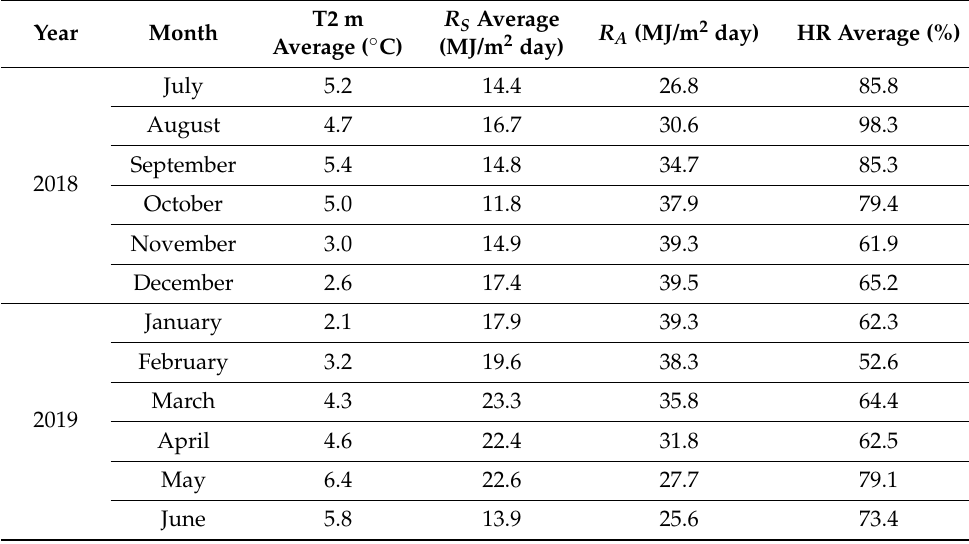
Table A1. Parameters for estimating the evaporation rate in Lakes El Sol and La